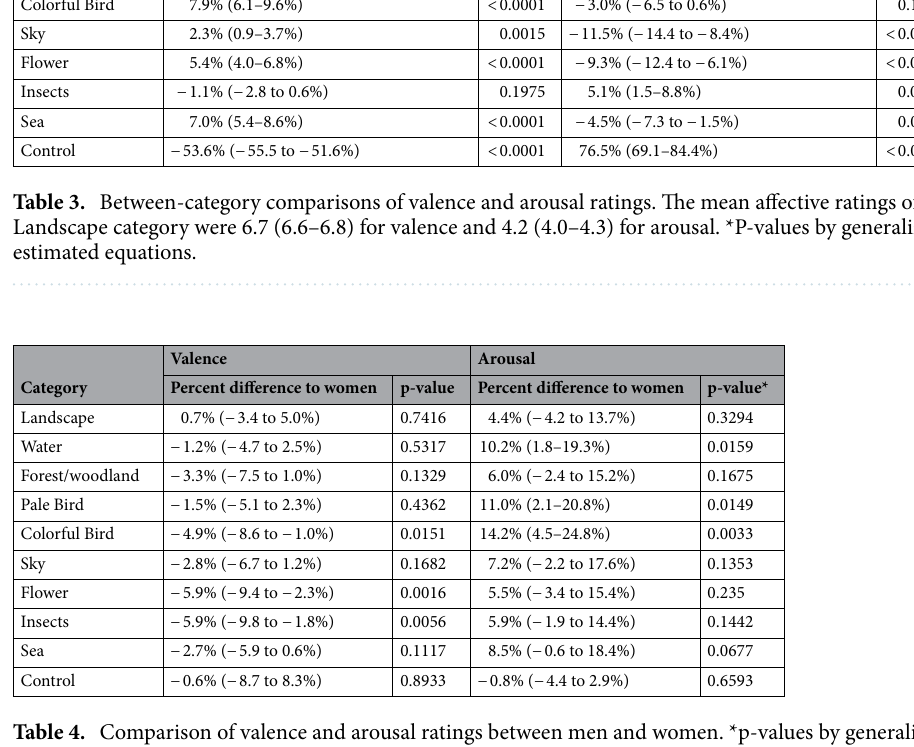
Table 4. Comparison of valence and arousal ratings between men and women. *p-values by generalized estimated equations calculated separately for each image category.